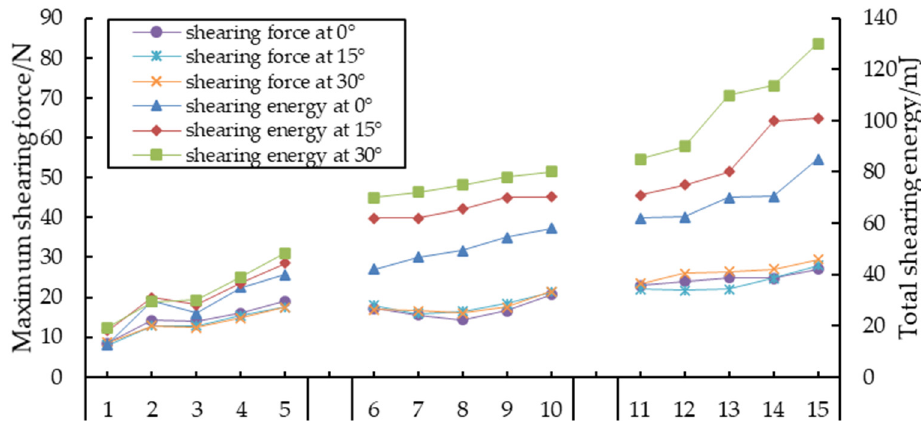
Figure 8. Shearing properties variation on whole stalk.